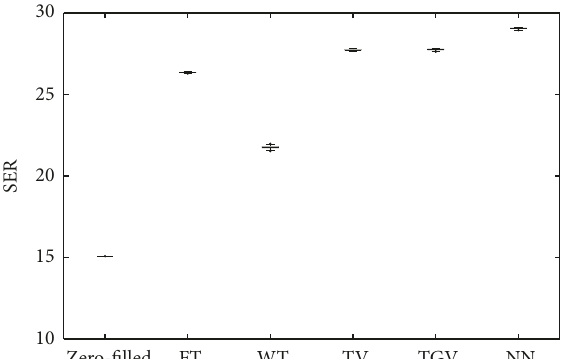
Figure 3: Boxplots of SER over 200 different sampling patterns. In the boxplot, the results of the five temporal regularizers are statistically different from each other except the ones between TV and TGV 2 𝛼 . We can observe that NN produced the highest SER, while WT yielded the lowest SER, which is an illustration of Table 2.